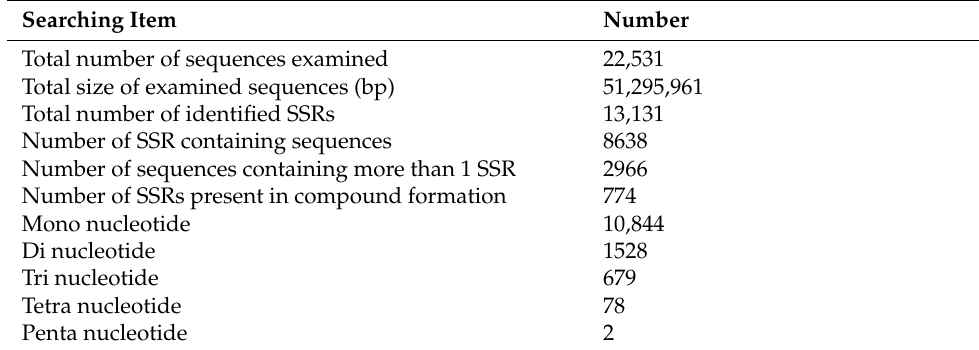
Table 3. Statistical data of SSR analysis.